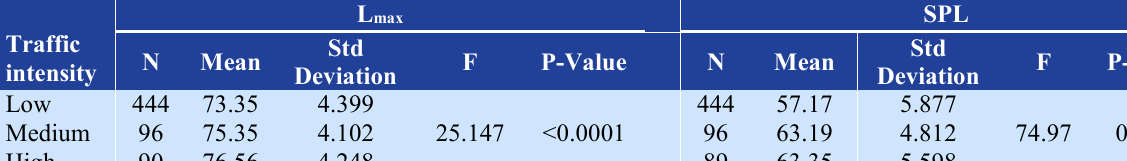
Table 4. Statistical analysis of L max and SPL based on traffic conditions